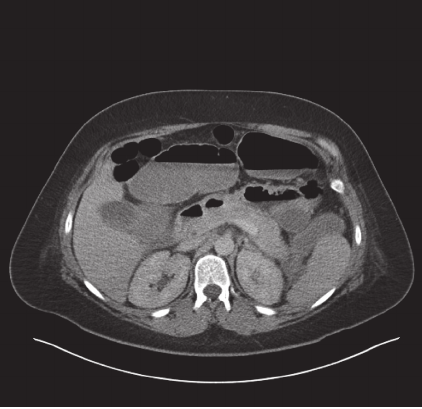
Figure 3: CT scan demonstrating large bowel obstruction with arrows showing cut-off at splenic flexure.